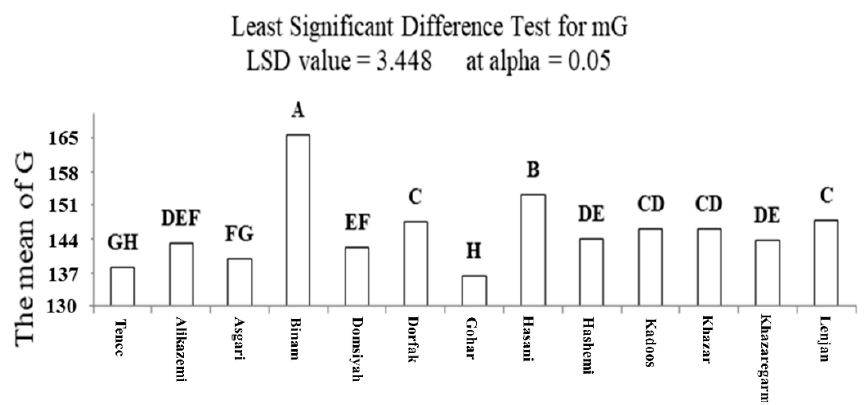
Figure 11. The results of the LSD test for the mean G of white rice cultivars.